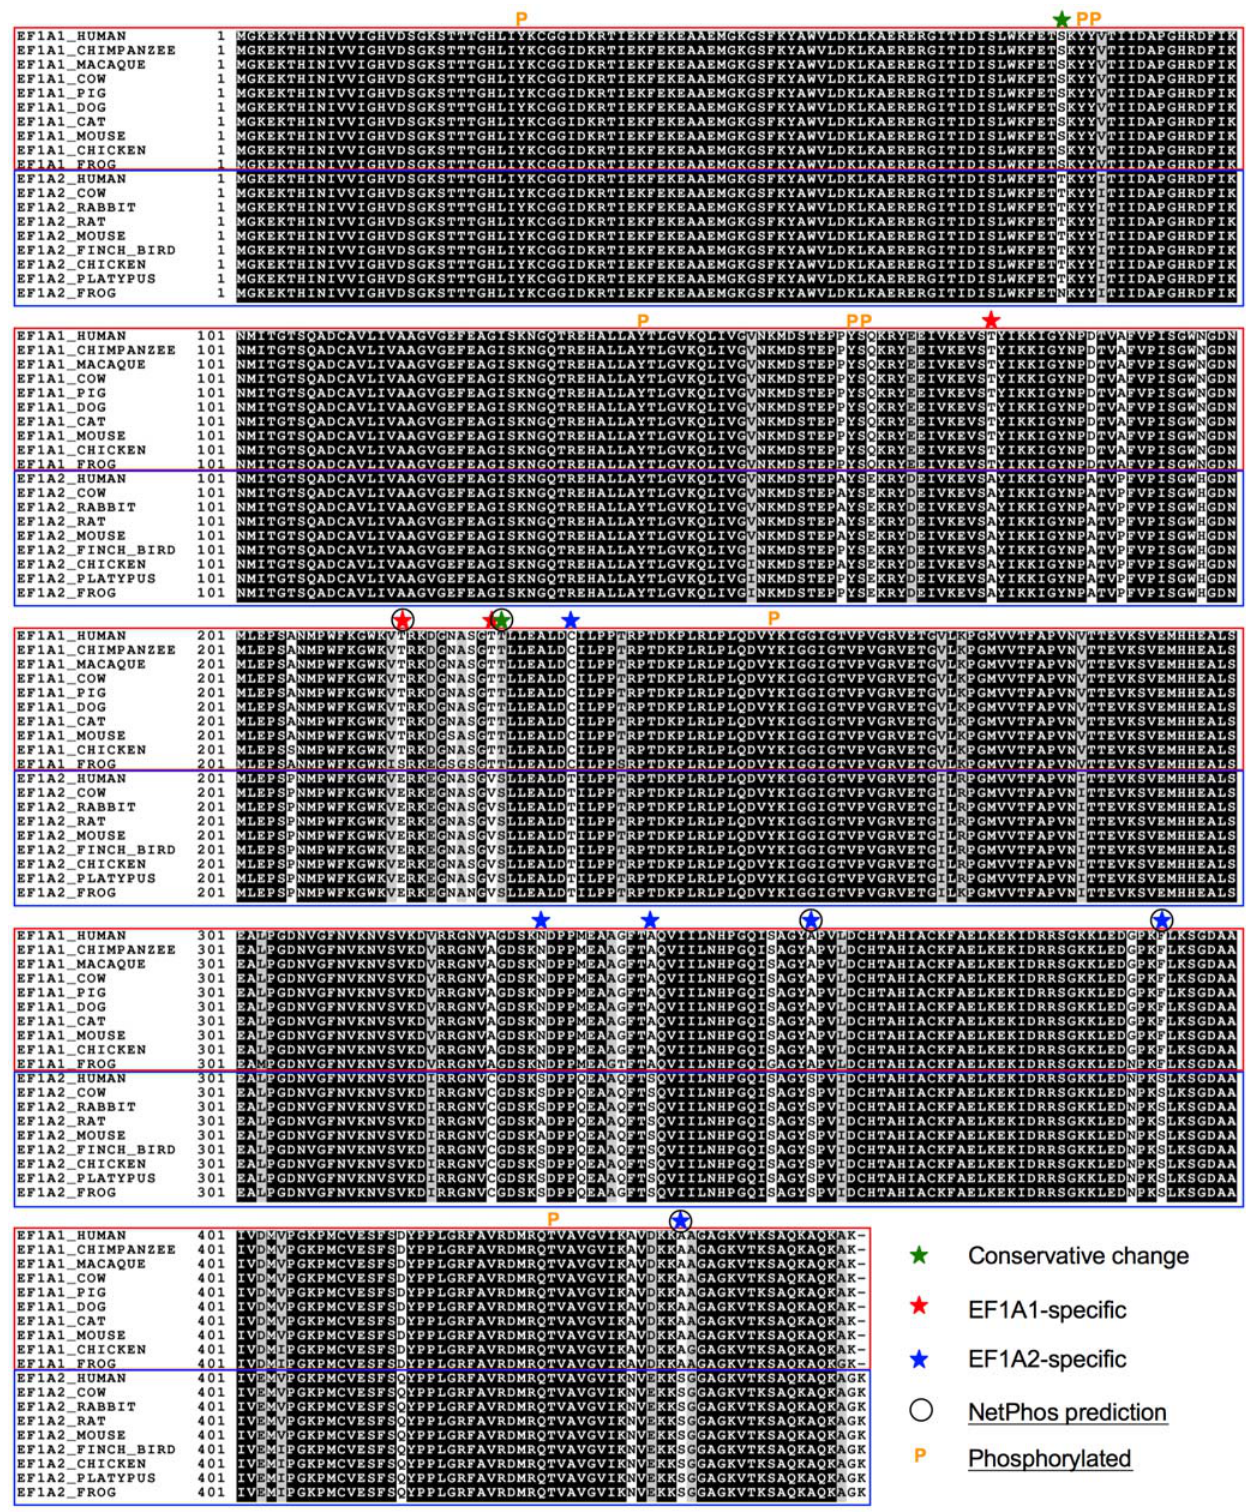
Figure 4. Multiple sequence alignment of eEF1A1 and eEF1A2 orthologues. ClustalX alignment of eEF1A1 and eEF1A2 sequences from a range of higher order eukaryotes. The results are shaded using BOXSHADE v3.21 (black background=strictly conserved; grey or white background=conservatively substituted or non-conserved). A star-symbol denotes the position of variant Ser and Thr amino acid residues for the two proteins and color-coded according to variant (red=eEF1A1-specific; blue=eEF1A2-specific). NetPhos-predicted phosphorylation sites are indicated by a circle, and experimentally determined phosphorylation sites shown with a ‘P’ symbol (these are mapped on the models in Supplementary file S6).